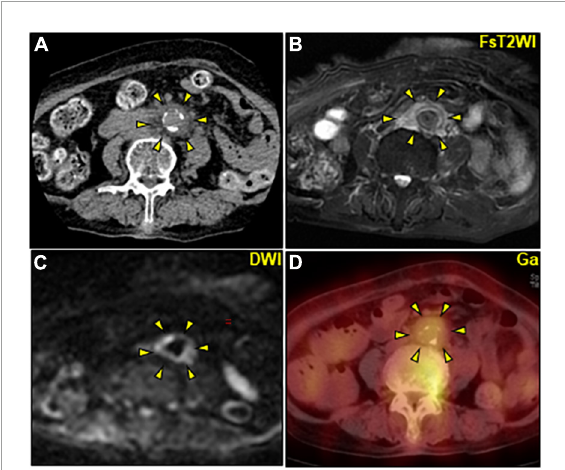
FIGURE1 Multimodality imaging of periaortic mass of the abdominal aorta. (A–D) Axial images. (A) Unenhanced CT image showing a non-dilated abdominal aorta with a maximum diameter of 17 mm including mural calcification surrounded by circumferential heterogeneous soft-tissue density (arrowheads). (B,C) Unenhanced abdominal magnetic resonance image. (B) FsT2WI showing significantly high signal intensity and marked thickening of the periaortic tissue of the abdominal aorta (arrowheads) with inhomogeneous diffusion restriction on DWI (C) . (D) Ga-single photon emission computed tomography/CT image revealing an active accumulation of Ga (arrowheads) corresponding to the periaortic mass. CT, computed tomography; DWI, diffusion-weighted imaging; FsT2WI, fat-suppressed T2-weighted image; Ga, gallium citrate-67.